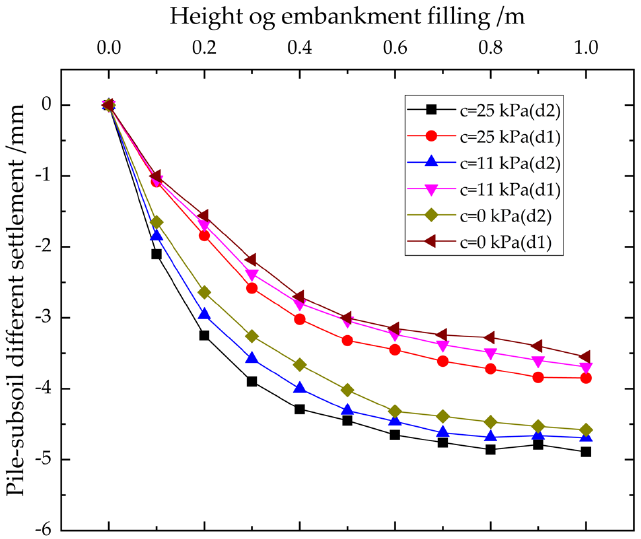
Figure 8. Effect of filling cohesion on pile-subsoil differential settlement.